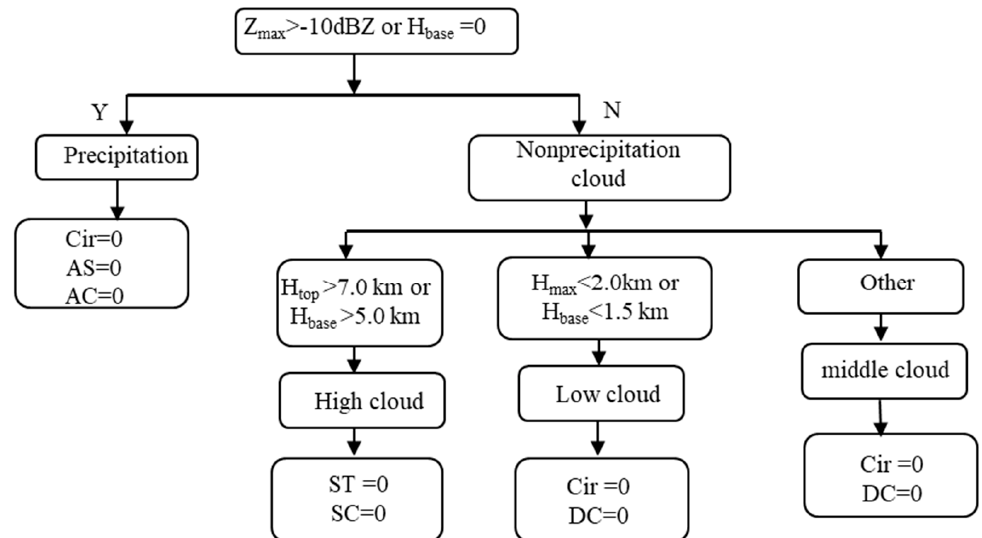
Figure 1. Scheme of cloud classification. The first guessed membership value is modified using the proposed method.